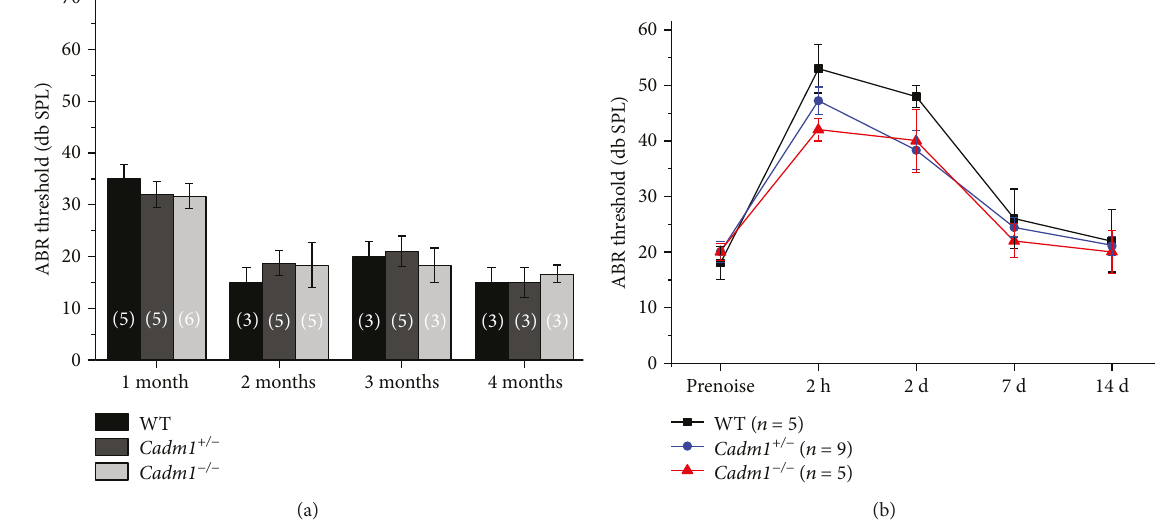
Figure 7: Auditory brainstem response (ABR) measurements show normal auditory function of Cadm1 knockout mice. (a) ABR thresholds of wild-type, Cadm1 +/ − , and Cadm1 − / − mice to click stimuli were measured at di ff erent ages as indicated. (b) Wild-type, Cadm1 +/ − , and Cadm1 − / − mice at P45 were subjected to 2 – 8 kHz noise at 96dB DSL for 2 hours, and ABR thresholds were measured preexposure and at di ff erent postexposure time points as indicated. Variance bars indicate standard error. No signi fi cant di ff erences were observed between genotypes. The numbers of animals for each group used in the experiments are